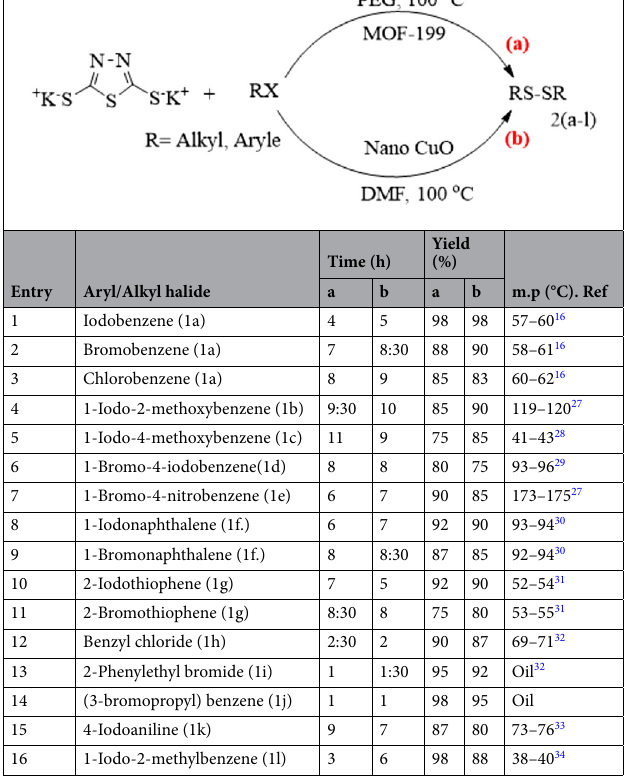
Table 2. Synthesis of disulfides a . a: Reaction conditions: aryl or alkyl halide (1 mmol),